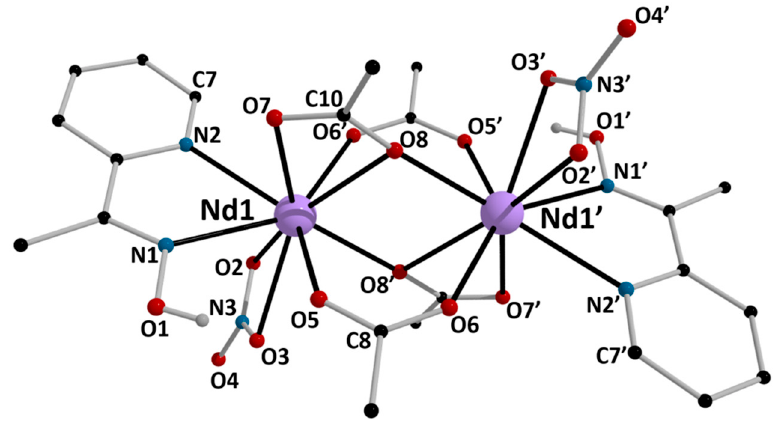
Figure 3. Partially labeled plot of the structure of the dinuclear molecule [Nd 2 (O 2 CMe) 4 (NO 3 ) 2 (mepaoH) 2 ] that is present in the crystal of 1 . Symmetry operation: (‘) = – x +2, − y+1, – z +2.